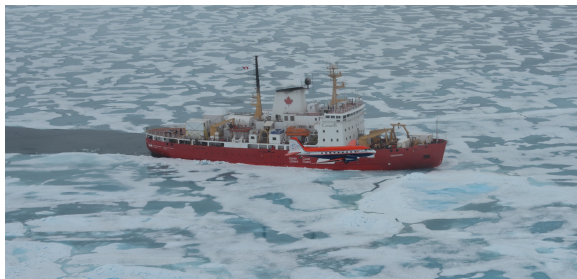
Figure 1. Snapshot of Polar 6 aircraft while sampling Amundsen’s plume during ice-breaking in Lancaster Sound (Photo credit: Mau- rice